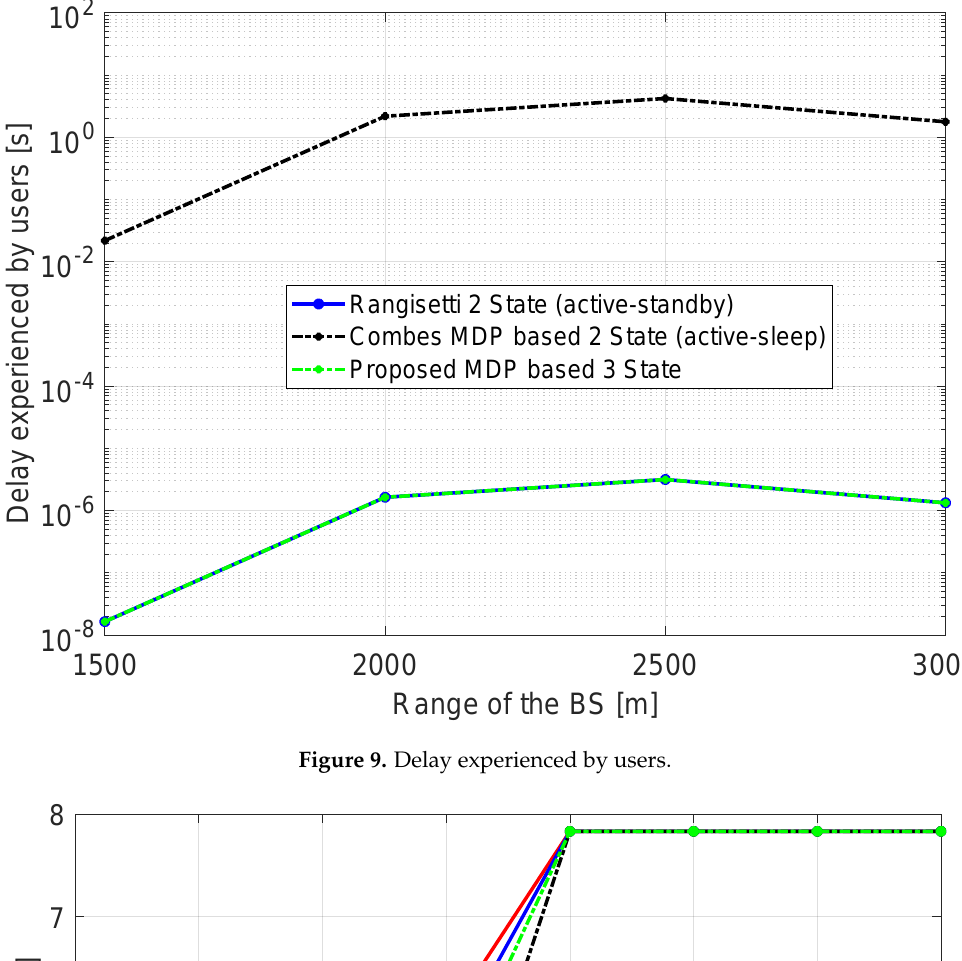
Figure 9. Delay experienced by users.